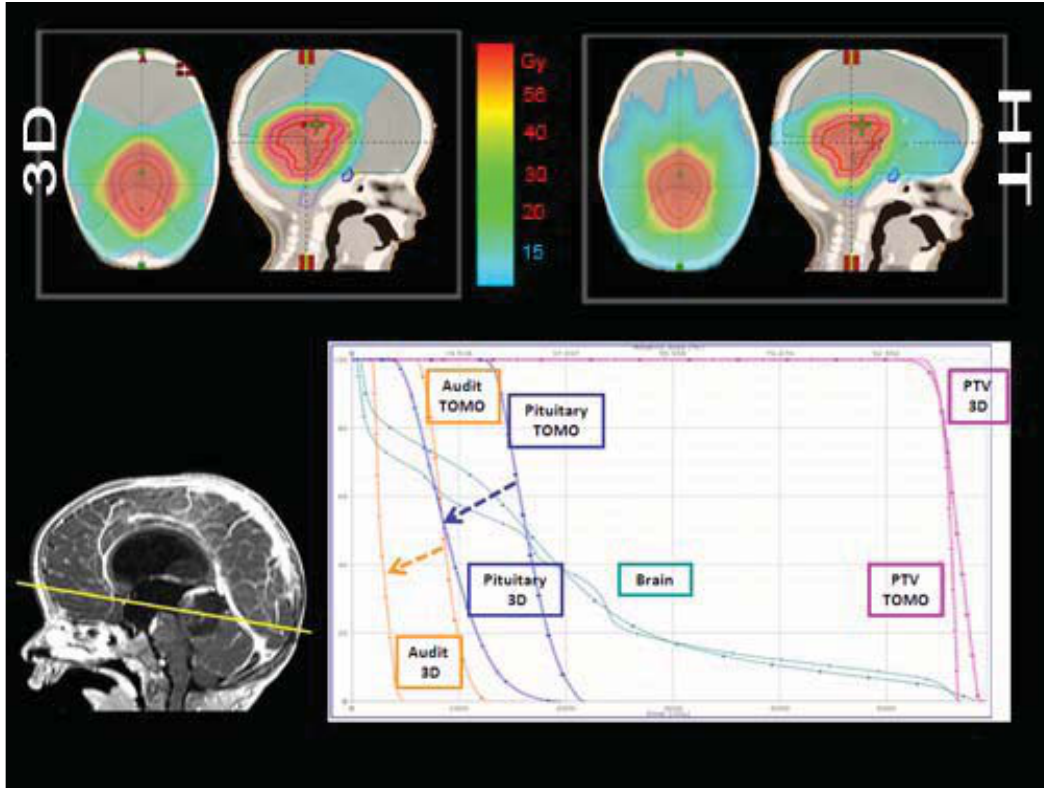
Figure 2. A comparison between no-coplanar 3D-CRT and Tomotherapy plans is shown in a 2-year-old male affected by atypical teratoid rhabdoid brain tumor. The DVH analysis for pituitary gland and audit and total brain are in favor of 3D-CRT.